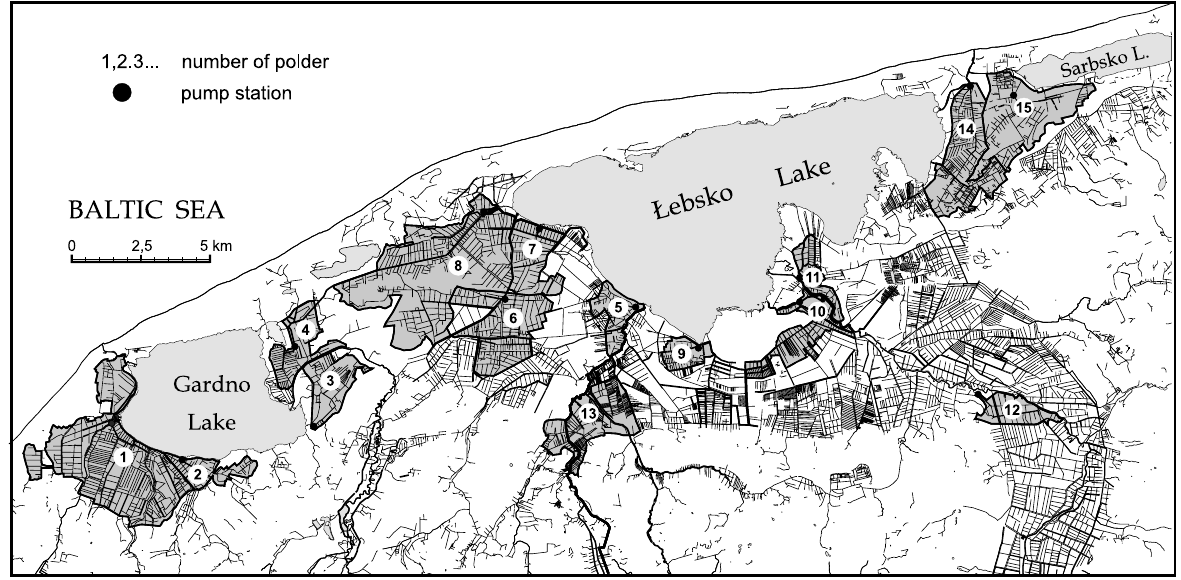
Fig. 6. Polders and pump stations in the Gardno-Łeba Lowland in the early 20th c. (number of polder corresponds to the number in the Table